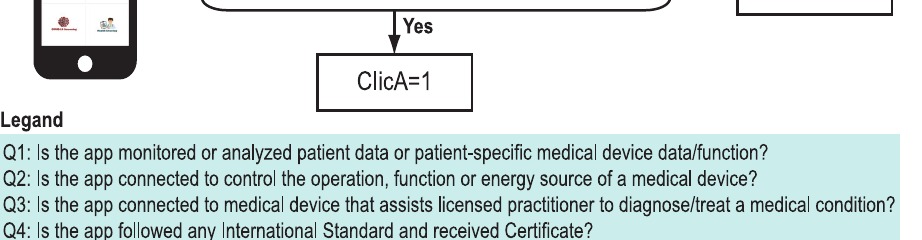
Fig 6. Calculation of clinical approval